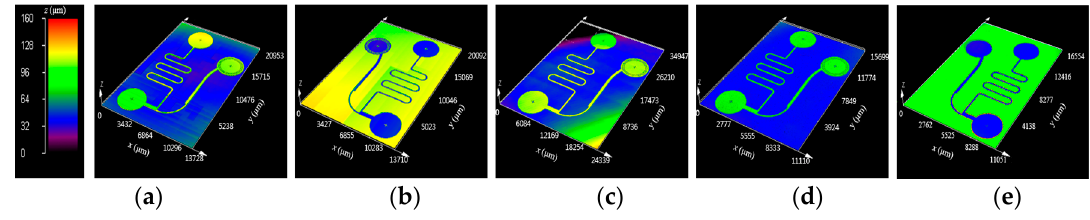
Figure 5. 3D microscope images of the ( a ) master pattern on Si wafer; ( b ) polydimethylsiloxane (PDMS) mold; ( c ) furan precursor; ( d ) AC mold; and ( e ) replicated glass microfluidic structure. Micromachines 2017 , 8 , 67